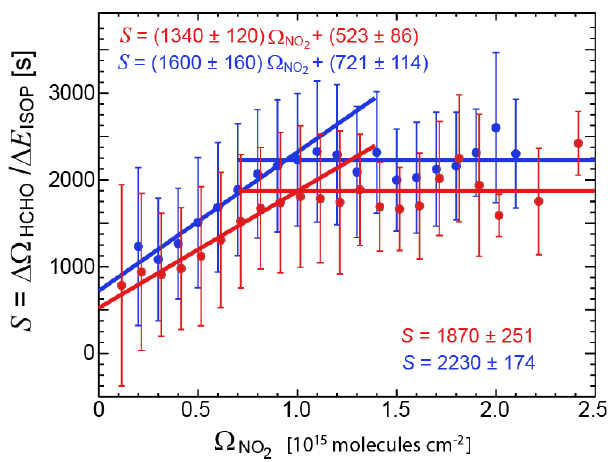
Fig. 9. Dependence of the HCHO-isoprene relationship on the local tropospheric NO 2 column (cid:127) NO over Africa in GEOS-Chem. The 2 figure shows statistics of S = 1(cid:127) HCHO / 1E ISOP computed as de- scribed in the text for individual 2 × 2.5 ◦ gridsquares and months in 2006 at 12:00–15:00LT. Values of S have been sorted by the local value of (cid:127) NO in 1 × 10 14 moleculescm − 2 bins, and means and 2 standard deviations are shown in each bin for GEOS-Chem using the standard isoprene oxidation scheme (red) and the Paulot scheme ≤ 1 × 10 15 moleculescm − 2 show a lin- (blue). The data for (cid:127) NO 2 ear relationship between S and (cid:127) NO , and reduced-major-axis re- 2 gression parameters are shown inset with standard deviations de- termined using jackknife resampling (Manly, 1997). The data for (cid:127) NO > 1 × 10 15 moleculescm − 2 show no significant dependence 2 between S and (cid:127) NO , and the corresponding mean values and stan- 2 dard deviations of S are shown